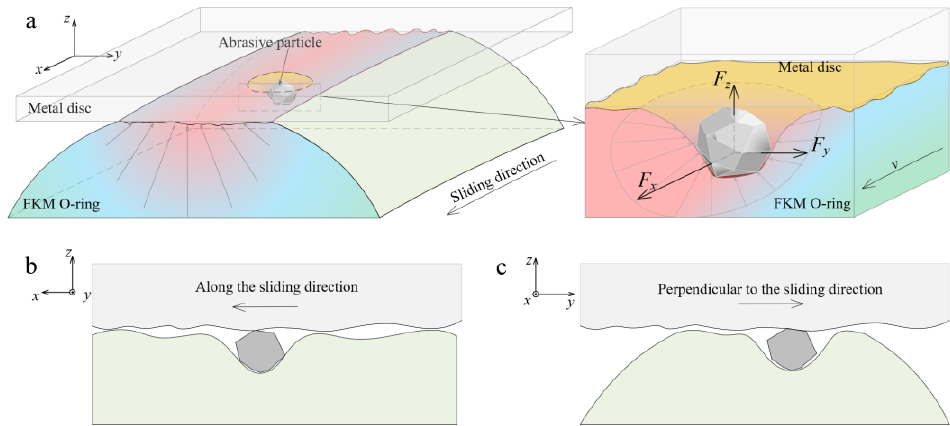
Figure 11. Schematic of ( a ) three-body abrasion of FKM O-ring, and the particle movement ( b ) along the sliding direction and ( c ) perpendicular to the sliding direction.